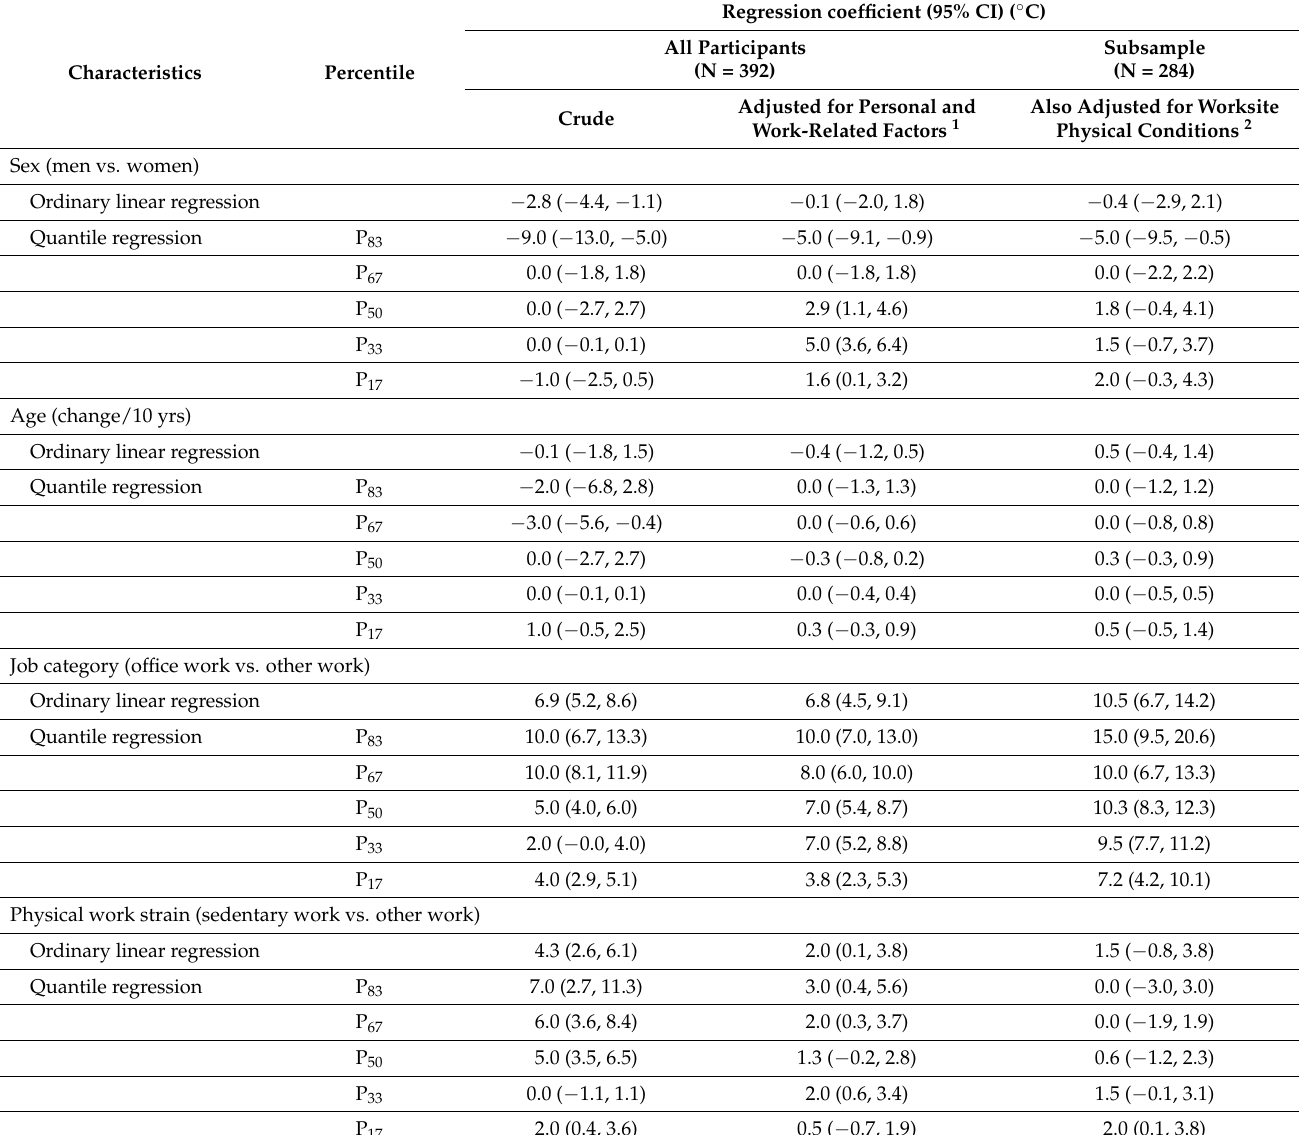
Table 2. Regression of self-assessed cold threshold on personal characteristics and work-related factors. Regression coefficients indicate the difference ( ◦ C) in self-assessed threshold temperature in each class compared with the reference class. Percentiles arranged from warmest (P 17 ) to coldest (P 83